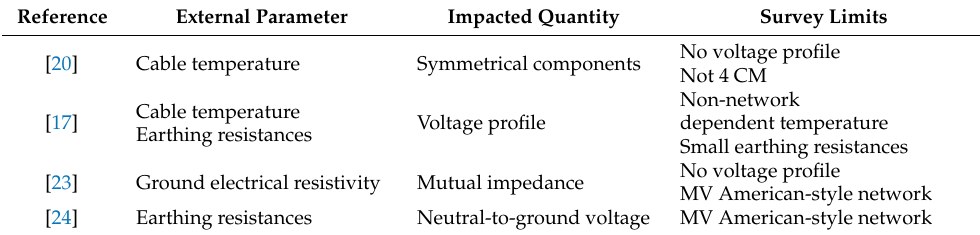
Table 2. Impact of external parameters in the